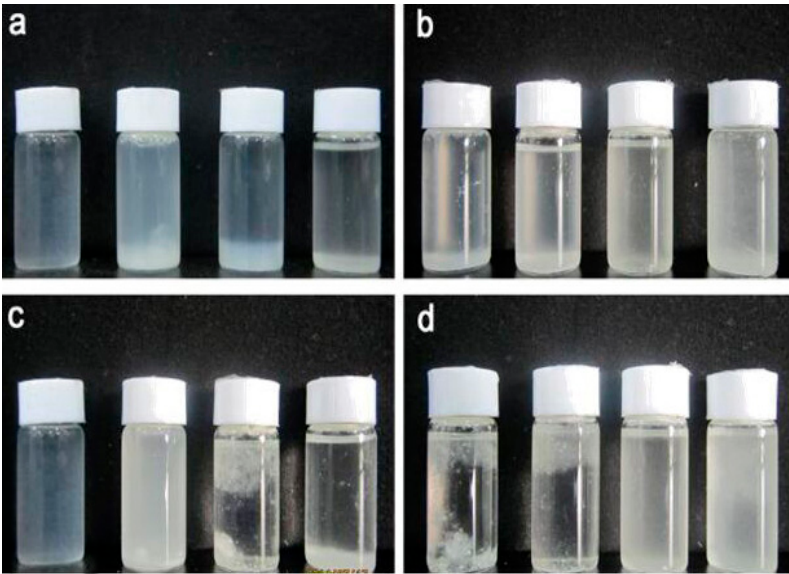
Figure 5. Photographs of CNC or ACNCs after redispersion: ( a ) CNC was dispersed in water, methanol, chloroform, and n-butanol. ( b ) ACNC-40 °C was dispersed in water, methanol, chloroform, and n-butanol. ( c ) CNC, ACNC-20 °C, ACNC-30 °C, and ACNC-40 °C were dispersed in water. ( d ) CNC, ACNC-20 °C, ACNC-30 °C, and ACNC-40 °C were dispersed in chloroform.